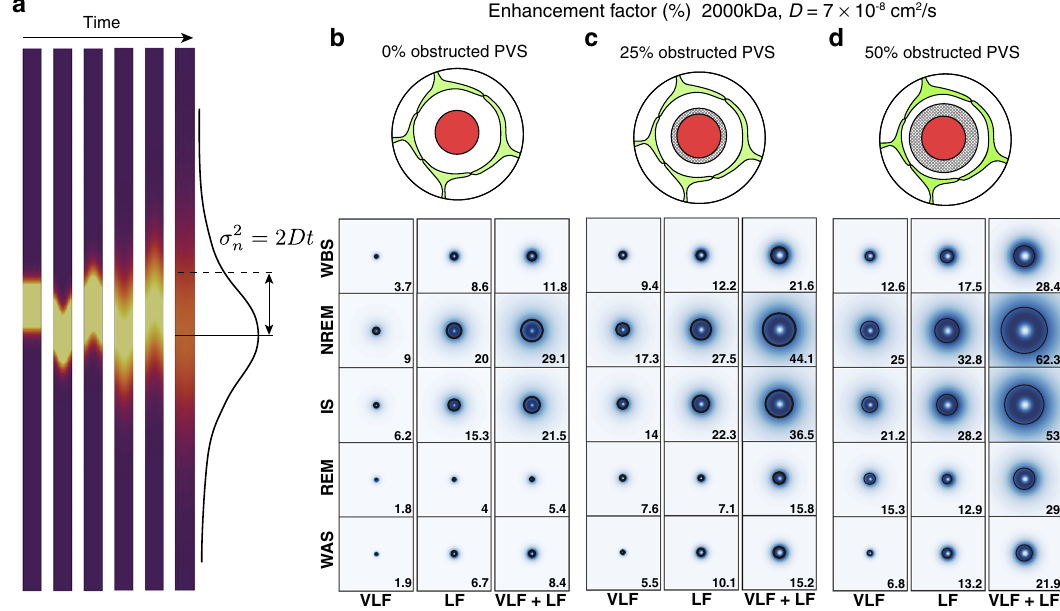
Fig. 4 | NREM/IS slow vasomotion enhances predicted dispersion in PVS. a Modeling of the slow vasomotion driven tracer spread in the PVS. b – d Enhancement factor for 2000 kDa tracer spread in penetrating arteriole PVS generated by VLF and LF oscillations during a sleep cycle as predicted by bio- mechanical modeling using three scenarios where we added a fi xed volume to the PVSobstructing fl owcorrespondingto0,25,and50%ofourmeasuredPVSinquiet wakefulness. The enhancement factor is the relative increase in solute movement